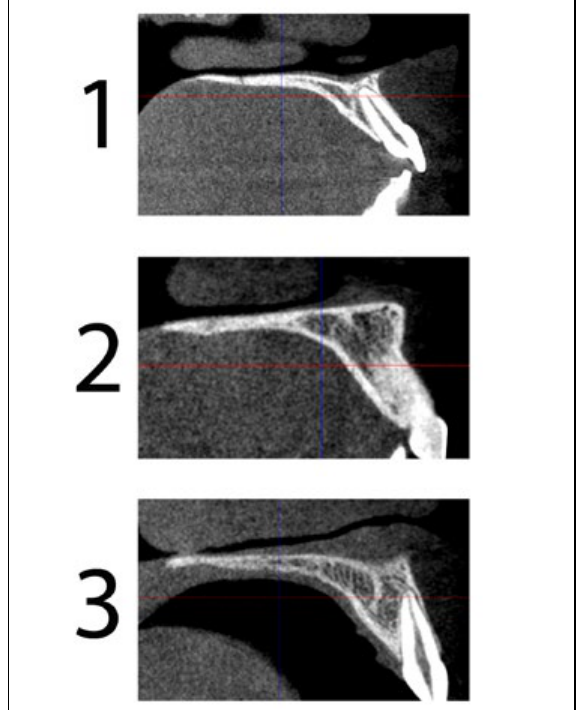
Figure 3. Diagnoses of the transverse palatal suture: 1 – suture space could be distinguished from the surrounding hard tissue along the whole thickness of the hard palate. 2 – suture space could be distinguished from the surrounding hard tissue along part of the thickness of a hard palate, 3 – suture space could not be distinguished from the surrounding hard